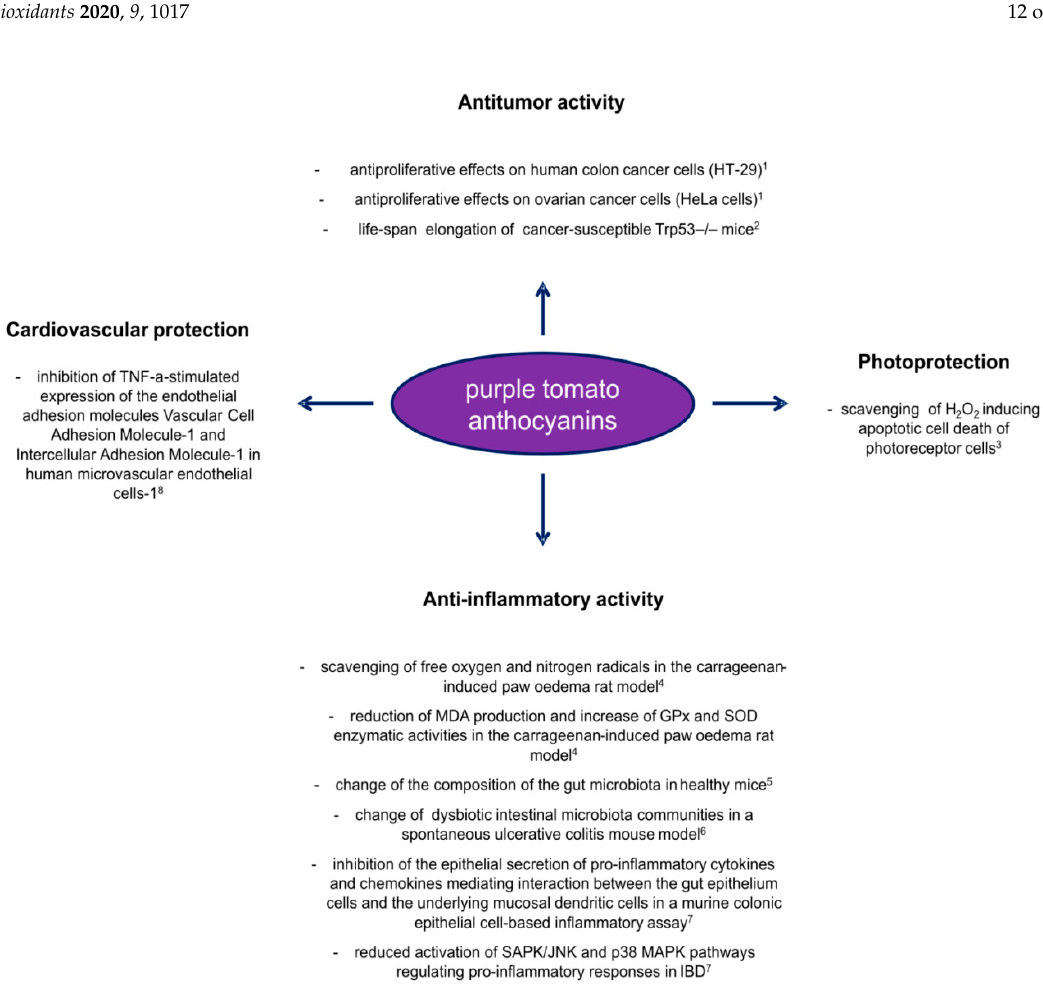
Figure 3. Overview of the positive e ff ects carried out by anthocyanins from purple tomato lines as health beneficial molecules. Results from in vitro and in vivo studies published in recent years: 1 [60]; 2 [52]; 3 [62]; 4 [64]; 5 [86]; 6 [87]; 7 [88]; 8 [10].